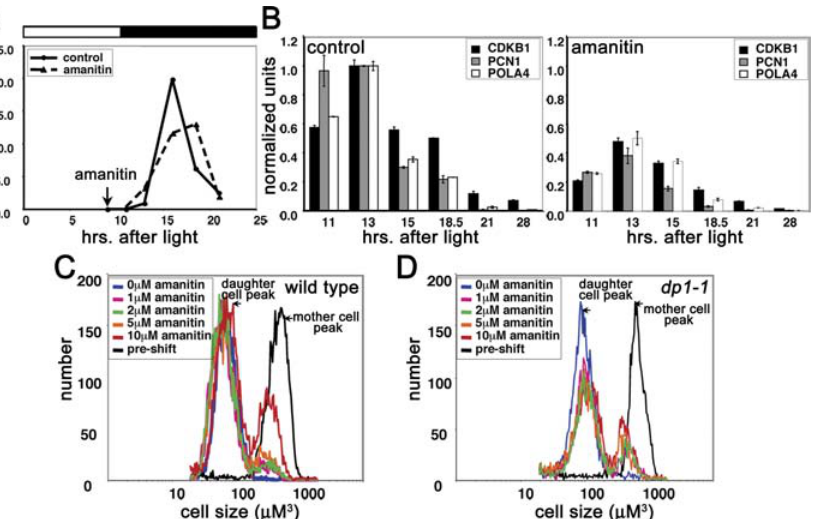
Figure 9. Cell Division in the Presence of RNA Polymerase II Inhibitor a -Amanitin (A) a -Amanitin 10 l M was added to 12:12 light/dark synchronized wild-type cells at 9 h in the light period (vertical arrow), and the drug-treated or control cultures were dark-shifted at 10 h. The cells stayed in the dark for the remainder of the experiment. The mitotic index was measured for each culture as indicated. (B) Quantitative RT-PCR of S/M phase markers CDKB1 , PCN1, and POLA4 from control and a -amanitin–treated cultures at different times. (C, D) Dose response of synchronized wild-type (C) or dp1–1 (D) cells treated with different concentrations of a -amantin prior to cell division. Mother cell size distribution is shown by the black curve (pretreatment), and postmitotic daughter cell sizes produced in different concentrations of a -amantin by the different color curves. DOI: